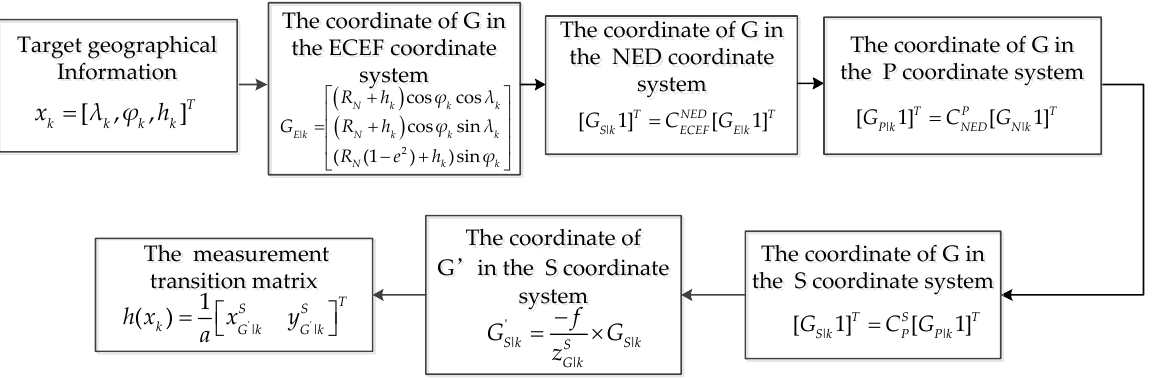
Figure 6. The solution process of the function h ( x k )